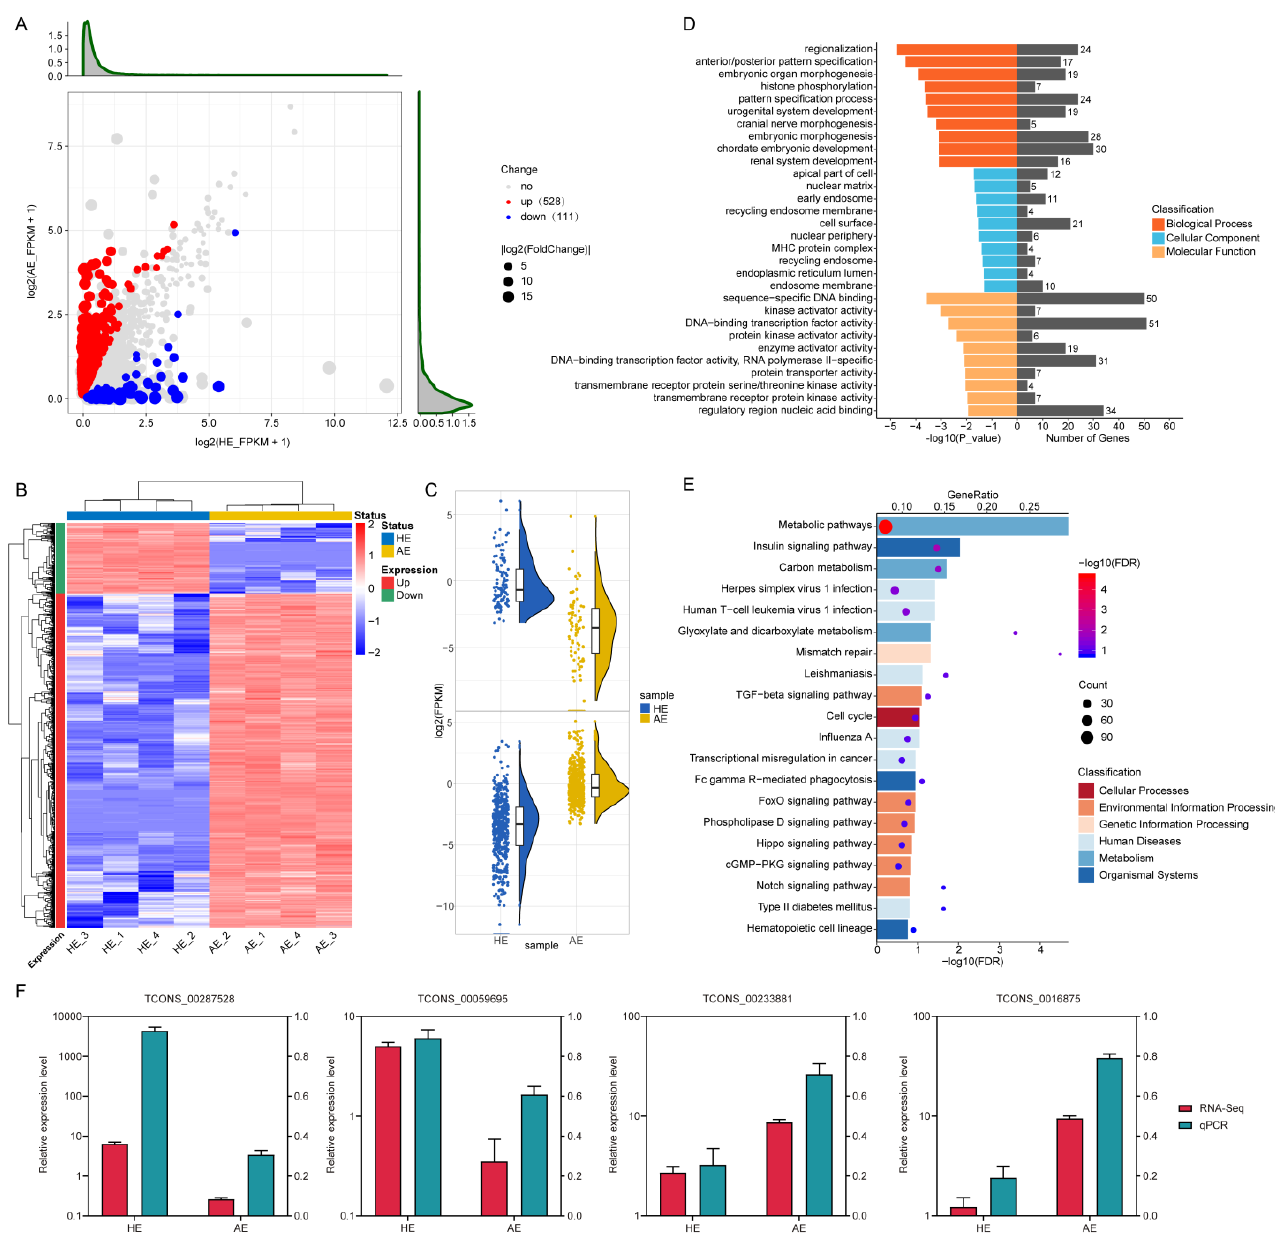
Figure 3. Screening and enrichment analysis of the differentially expressed lncRNAs (DELs) in AE compared with HE. ( A ) DELs expression profile by scatter plot. Each point represents one lncRNA. The red points represent upregulated lncRNAs while the blue points represent downregulated lncRNAs. ( B ) Hierarchical clustering heatmap of the DELs. The color scale is from -2.0 (blue, lower lncRNA expression level) to 2.0 (red, higher lncRNA expression level). Each row represents one lncRNA, and each column represents one sample. The red band on the left side of the heatmap represents clustering of the upregulated lncRNAs, and the green represents the downregulated lncRNAs. ( C ) Raincloud plot of the upregulated and downregulated DELs. ( D ) GO enrichment analysis of the DELs nearest target genes. ( E ) KEGG pathway analysis of the DELs nearest target genes. The different color represents the categories to which the KEGG pathway belongs. ( F ) Validation of the expression of genes using qRT-PCR. The relative expression level was normalized by